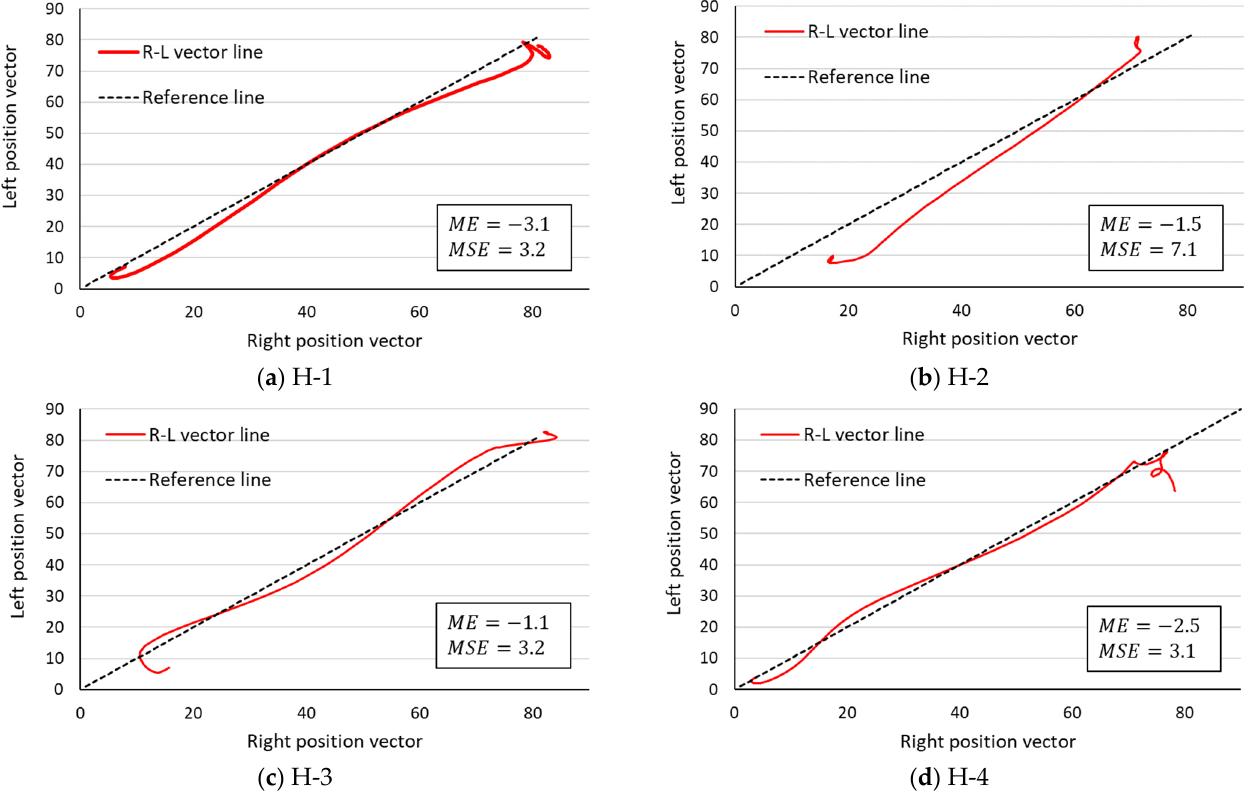
Figure 6. R–L vector line in the healthy group. The lower limb movement pattern is symmetrical enough to be drawn near the central symmetry reference line. H-1 through H-4 in the figure refer to each healthy participant in Table 1. Table 3. EA errors in both